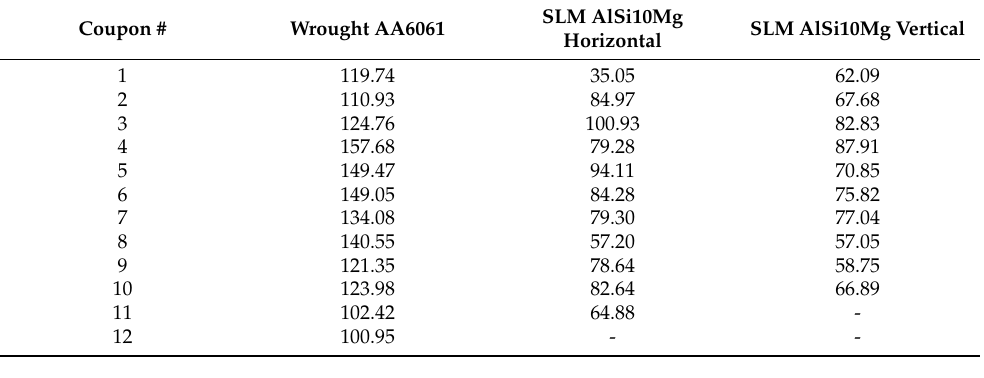
Table 10. Fatigue endurance limits of AlSi10Mg per coupon test.